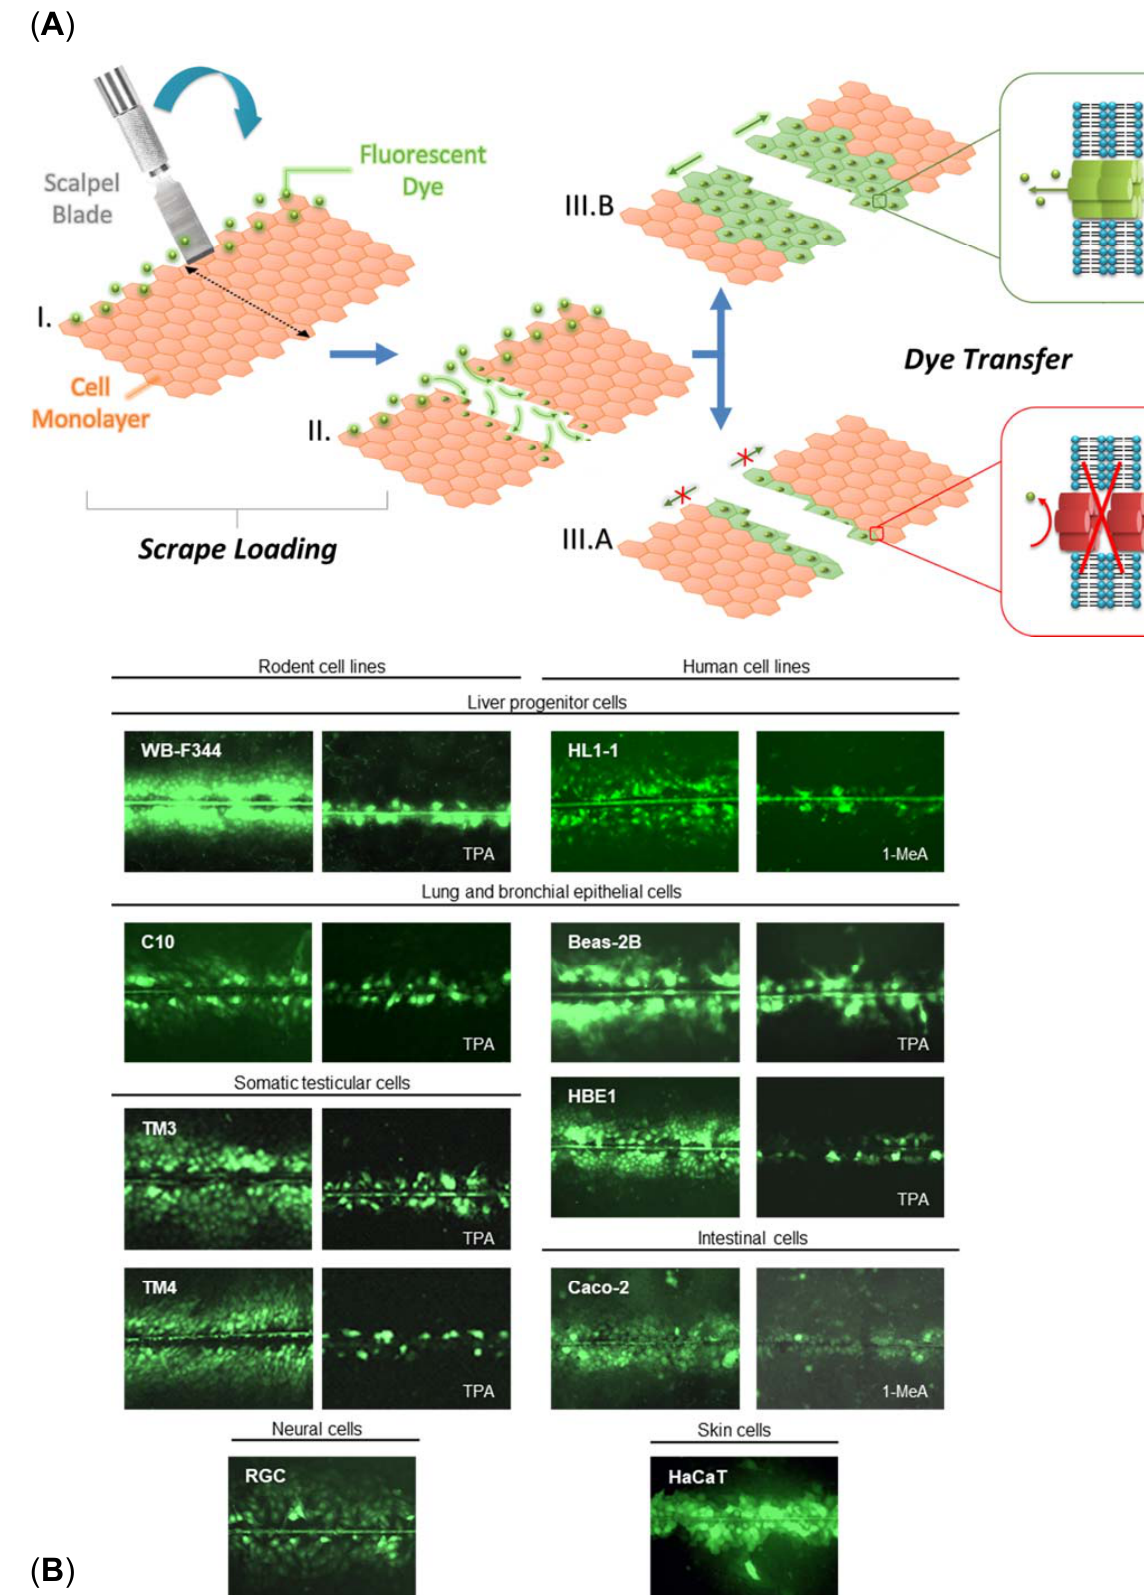
Figure 3. GJIC documented by the SL-DT technique in different cell lines. ( A ) Principle of the SL-DT assay. Fluorescent gap junction permeable dye (e.g., Lucifer Yellow) is loaded into the cell monolayer by a clean cut with a sharp scalpel blade